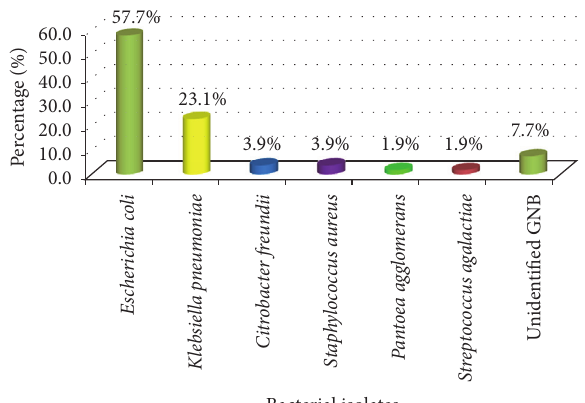
Figure 1: Bacterial species isolated from HIV-positive pregnant women with significant bacteriuria. Total number of bacteria is 52; two patients had dual bacterial infection; GNB: Gram-negative bacteria.